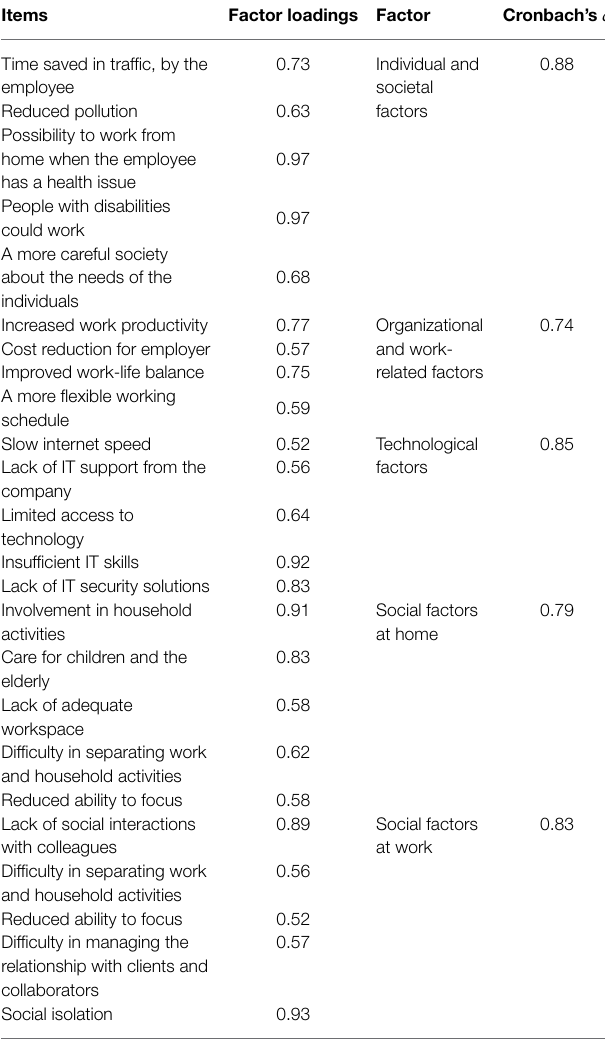
TABLE 2 | Testing data from employees’